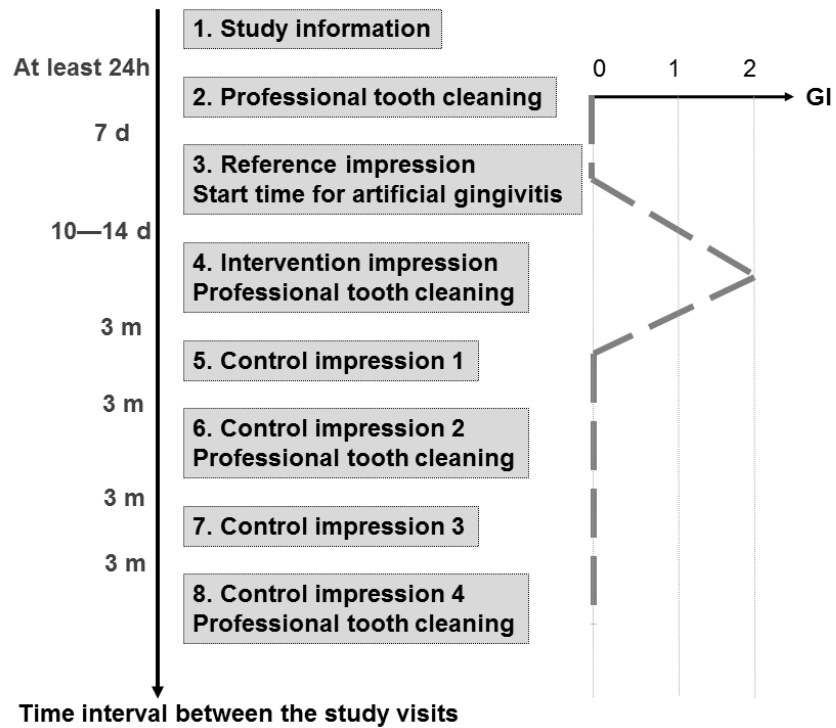
Figure 2. Study visits with intended course of the gingival index (GI). h: hours; d: days; m: months. Adapted with permission from [6]. 2021 MDPI.